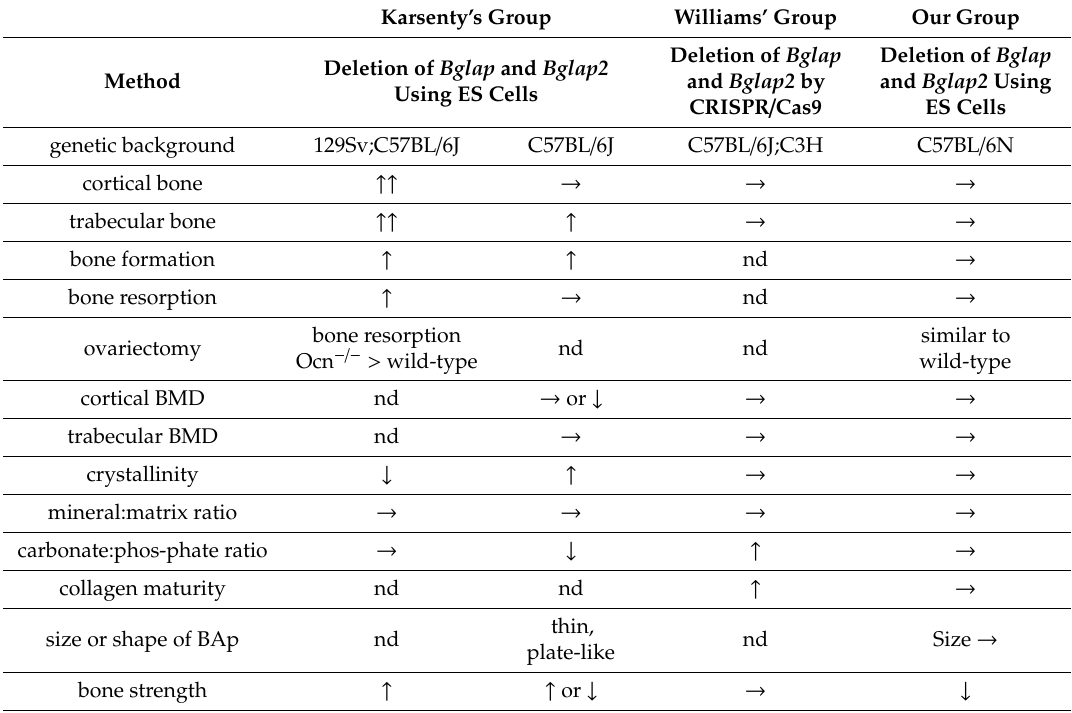
Table 1. Comparison of bone quantity and quality in osteocalcin (Ocn) − / − mouse lines. Karsenty’s Group Williams’ Group Our Group Deletion of Deletion of Bglap and Bglap2 Method Using ES Cells